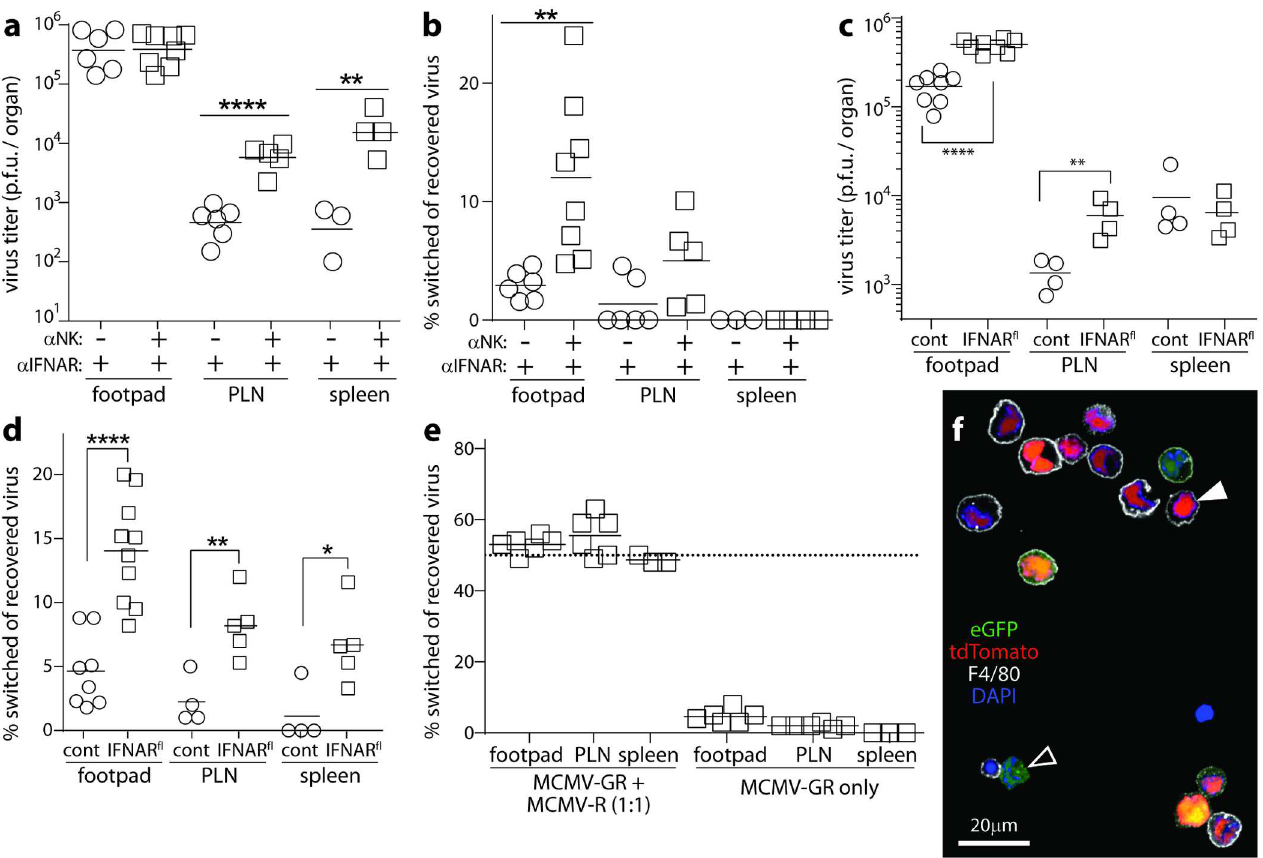
Fig 10. Limited MCMV replication in SSM suggests that they function mainly to limit FRC infection. (a). LysM-cre mice were given IFNAR blockingantibody( α IFNAR), without or without additionalNK cell depletingantibody ( α NK).They were then given MCMV-GR i.f. (10 6 p.f.u.). Footpads, PLN and spleensharvested3 days later were plaqueassayed for infectiousvirus. Squares and circles show individuals, horizontalbars show means. Significant differencesare indicated(Student’stwo tailedunpairedt-test; * p < 0.05, ** p < 0.01, **** p < 0.0001). (b). Viruses recovered in (a) were typed as green or red fluorescent. Squares and circles show the cre-driven green to red switchingrates of individualmice, horizontal bars show means. Significantdifferences are indicated(Student’s two tailed unpairedt-test with Welch’s correction; ** , P < 0.01) (c). LysM +/cre (cont) and LysM +/cre IFNAR flox/flox (IFNAR fl ) mice were depletedof NK cells then infected i.f. with MCMV-GR (10 6 p.f.u.). Virus titers and comparisons were determined as in (a) . (d). The viruses recovered in (c) were assayed for green to red switching. Significant differences were calculatedaccordingto (b) and are indicated( * , p < 0.05; ** , P < 0.01; **** , P < 0.0001). (e). The floxed colourswitch virus (MCMV-GR) and its switchedderivative (MCMV-R) were mixed 1:1 and given i.f. to lysM-cre mice (10 6 p.f.u.). As a control, mice were given MCMV-GR only. Viruses recovered after 3 days were assayed for green / red switching. The switching of MCMV-GR was < 5%. The mixed viruses remained 1:1 (50% switched). Therefore the low switchingof MCMV-GR was not due to poor fitness of the switched virus. (f). MCMV-GR was given i.p. to lysM-cre mice (10 6 p.f.u.). Two days later peritoneal macrophages were recovered by lavage,identifiedby stainingfor F4/80, and examinedfor viral fluorochrome expression. The closed arrow shows an exampleswitched macrophage, with red nuclear fluorescence. The open arrow shows an exampleunswitched infected cell (F4/80 - ) with cytoplasmic GFP fluorescence. Some F4/80 + cells showedresidualgreen fluorescence in addition to red fluorescence, but > 90% of fluorescentF4/80 + cells were